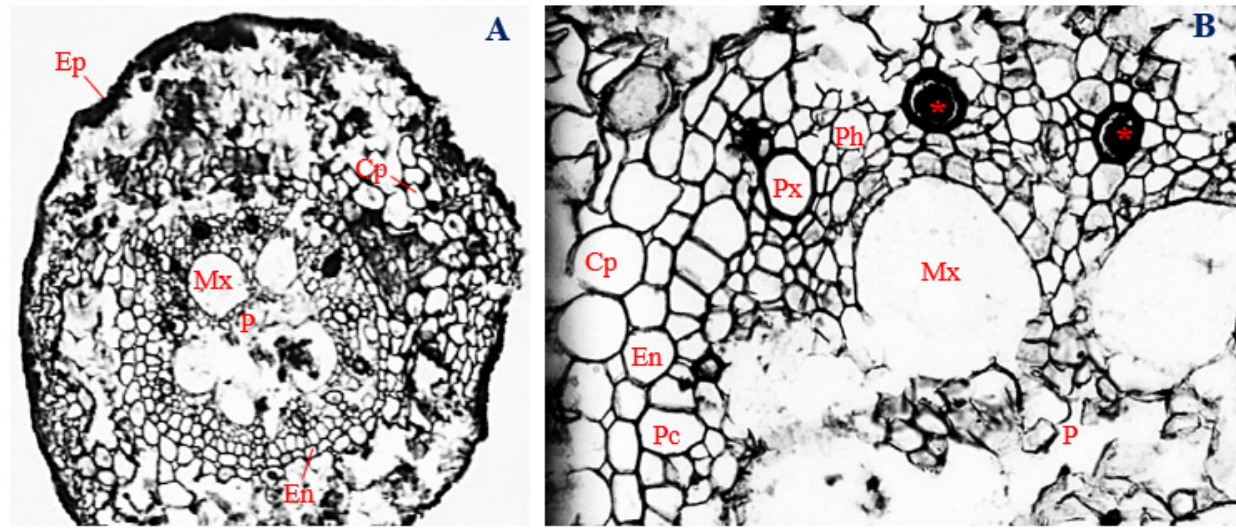
Figure 2. The transverse section of corn roots infected with endophytic Fusarium verticillioides. ( A ) Magnification 40×; ( B ) magnification 200×. Ep, epidermis; Cp, cortical parenchyma; En, Endodermis; Pc, pericycle; Px, protoxylem; Ph, phloem; Mx, metaxylem; and P, pith. Occluded xylem vessels are marked with asterisks (*).